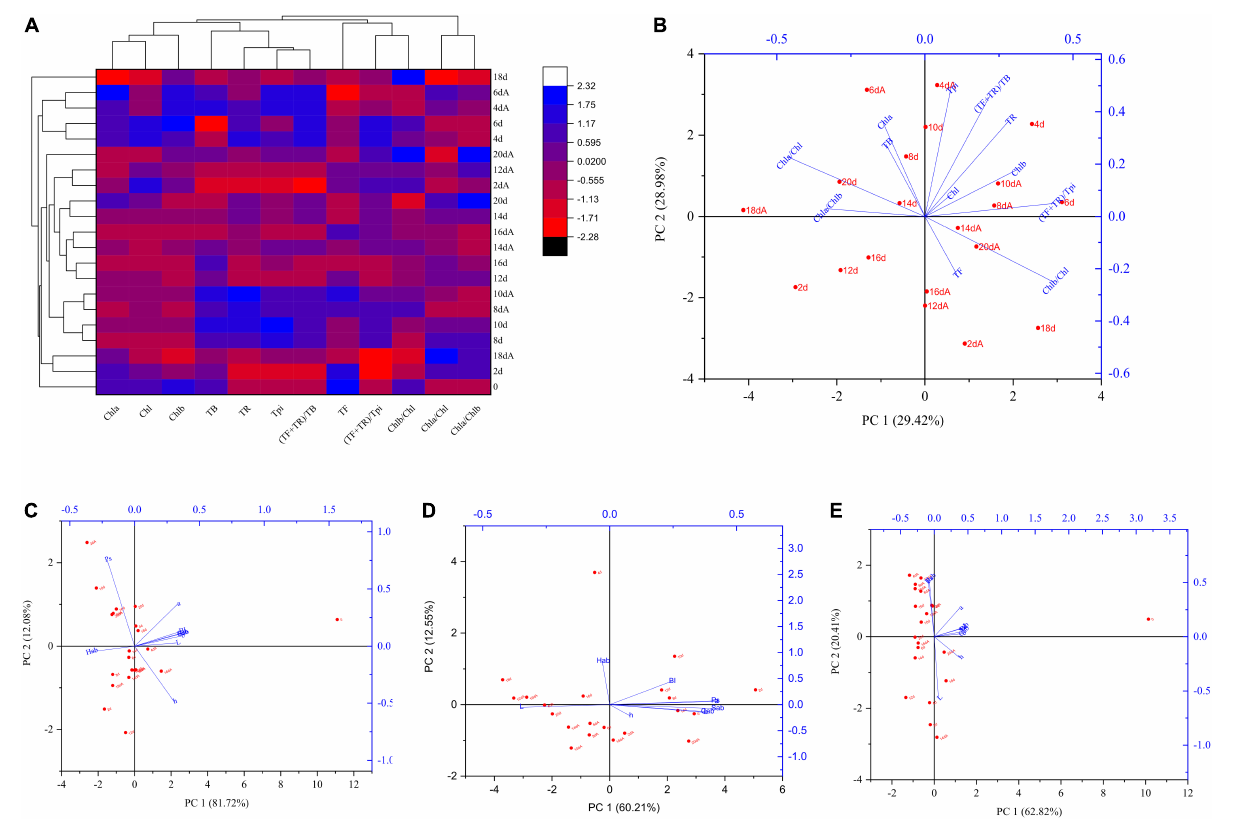
FIGURE 3 | Influence of Aspergillus niger M10 on SSDT color quality during fermentation. (A) Changes of sample color components during solid-state fermentation; each row and column in the heatmap represents samples at different fermentation times and a color component, respectively; the fermentation time marked with A represents AM10, while those unmarked represent the control. (B) PCA of samples undergoing solid-state fermentation based on color components. (C) PCA of dried tea CIELab parameters of different samples. (D) PCA of liquor tea CIELab parameters of different samples. (E) PCA of infused tea CIELab parameters of different